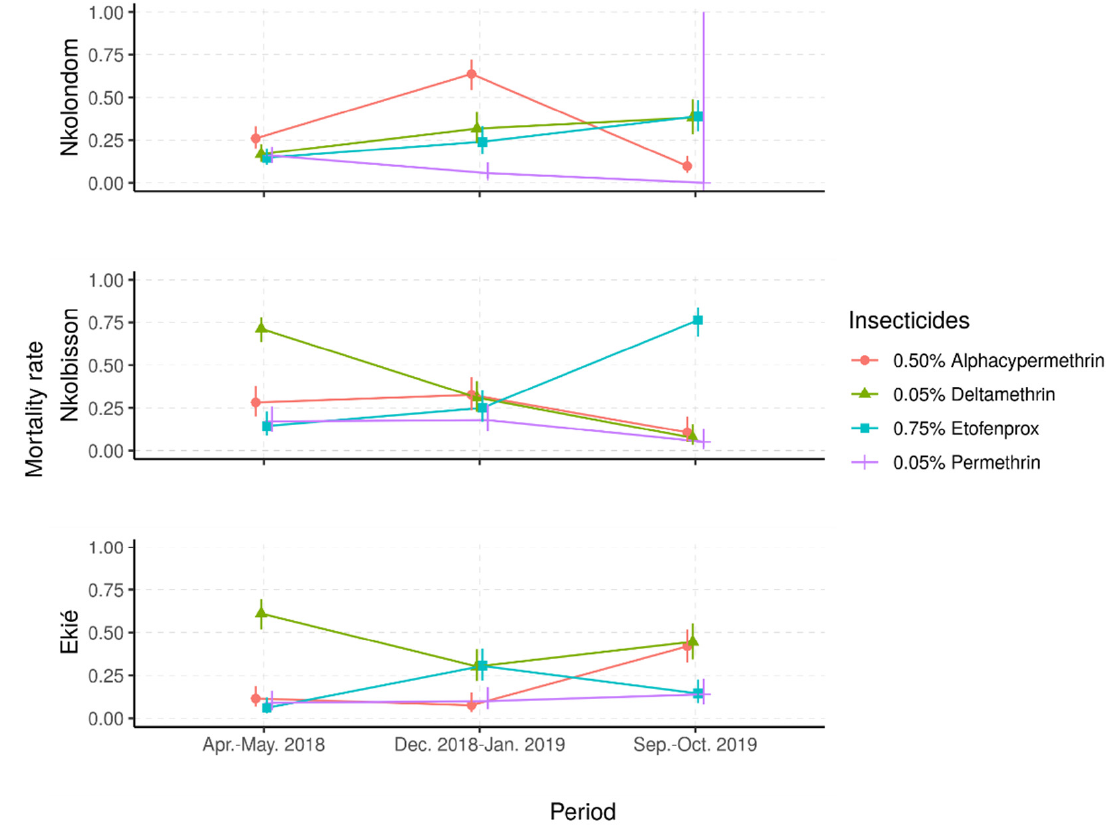
Figure 3. Predicted mortality rates and their 95% confidence intervals from a mixed-effects logistic regression model of field Anopheles gambiae s.l. samples following exposure to four insecticide diagnostic concentrations. (Apr.–May 2018: